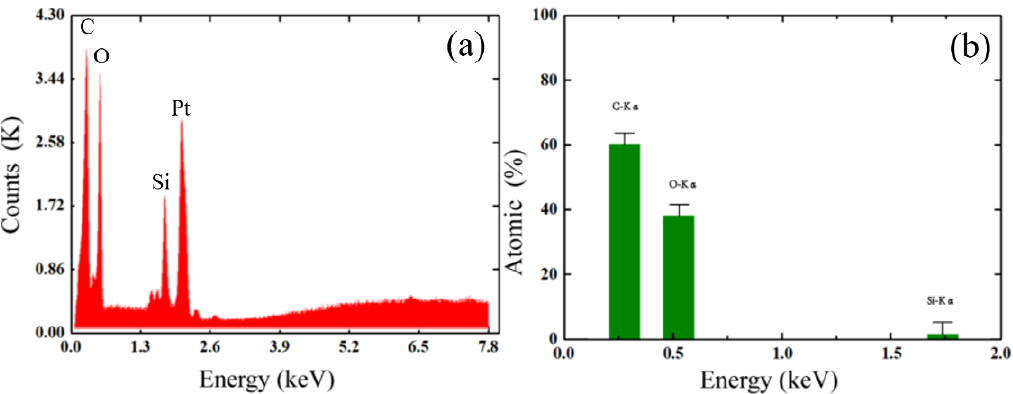
Figure 7. ( a ) EDS of GO coated on the surface of the tapered-TCF. ( b ) Atomic percentage of each major element.